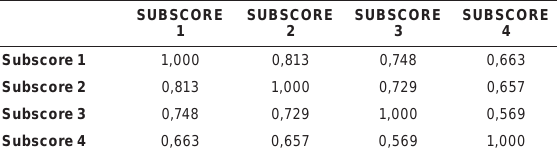
TAbLE 12 Matrix of intercorrelations of subscores (shortened